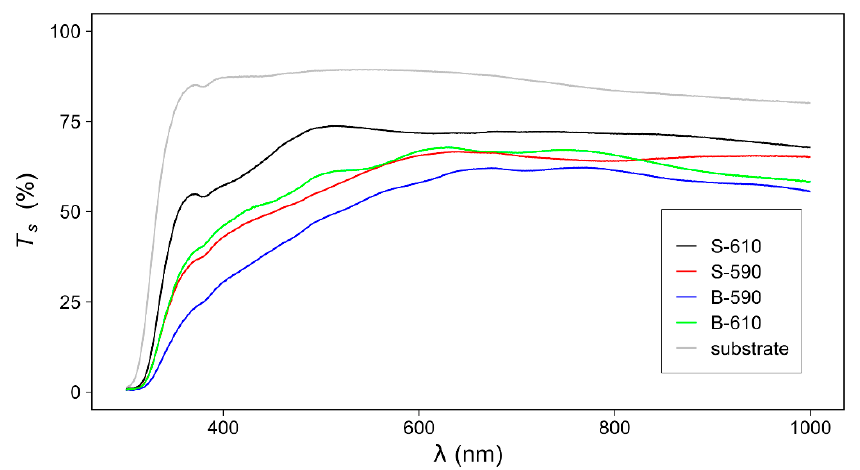
Figure 8. Measured transmittance T s in the UV-Vis-NIR spectral range for SnO 2 thin film samples. The transmittance of the glass substrate is added for comparison. Table 3. Values of the optical constants of SnO 2 thin films: optical band gap ( E g ), effective index of refraction ( n eff ) and surface roughness, determined from the haze ratio ( σ opt ) determined from UV-Vis-NIR